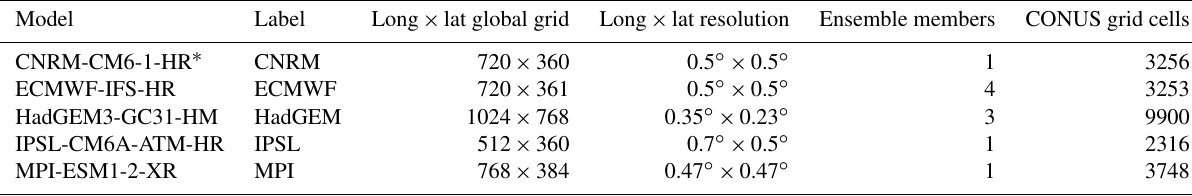
Table 1. HighResMIP climate model output used in the analyses for this paper. Model Label Long × lat global grid Long × lat